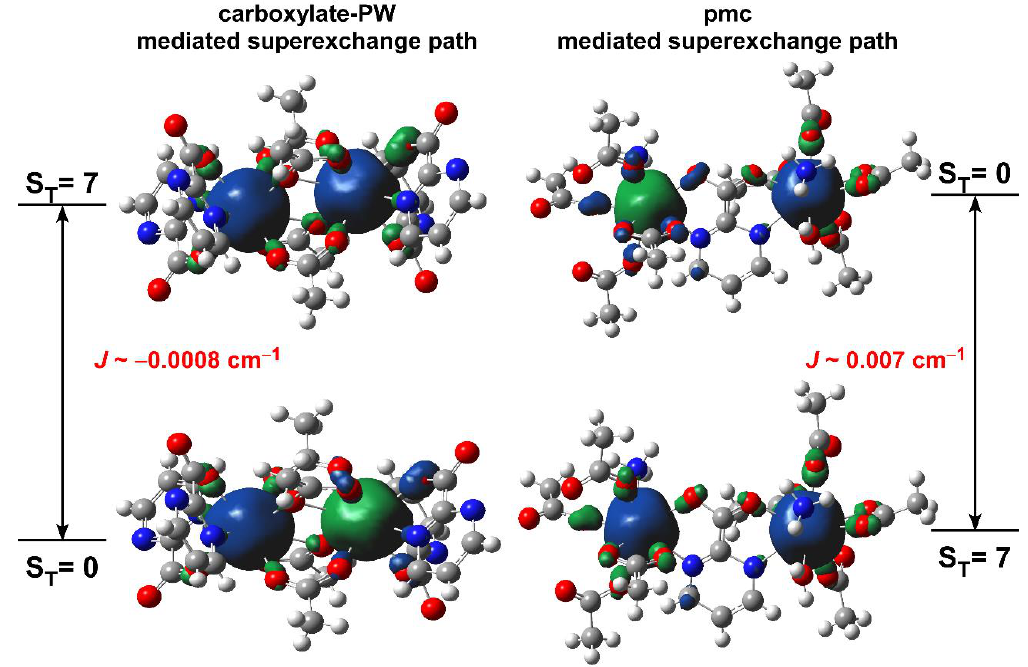
Figure 5. Broken symmetry DFT based calculation on an isostructural model grown with Dy 3 + centers to account for the value of the exchange parameter. Spin densities are shown for ground and excited states involving the two superexchange pathways.